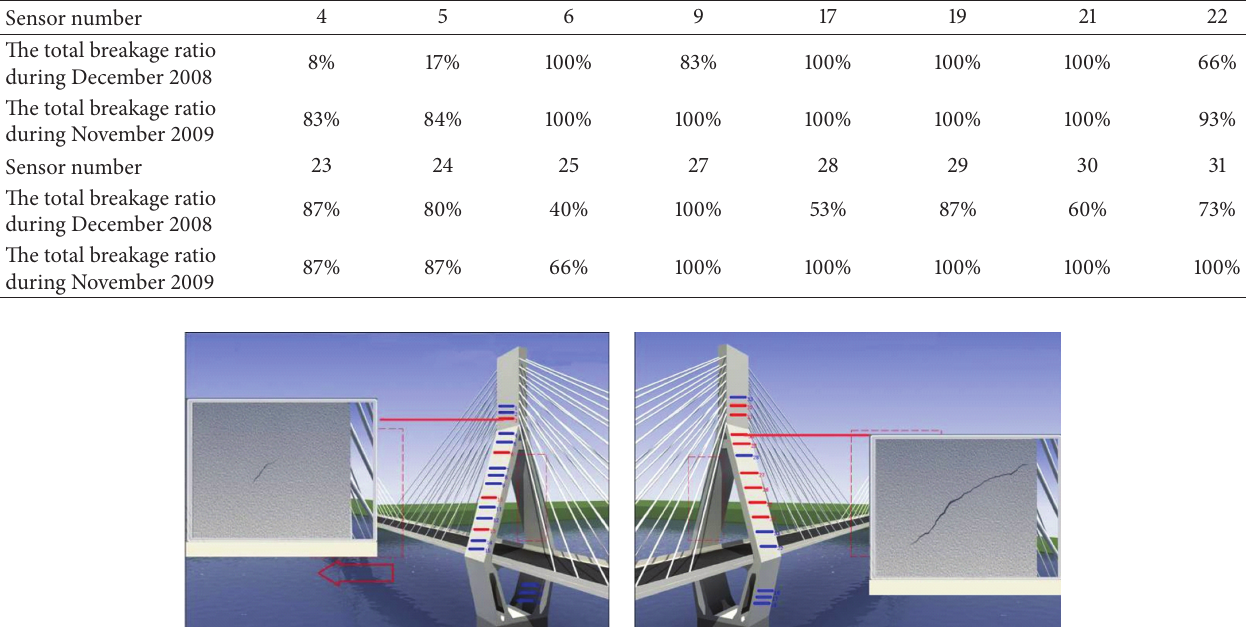
Table 2: Data of the smart films of tower no. 2.